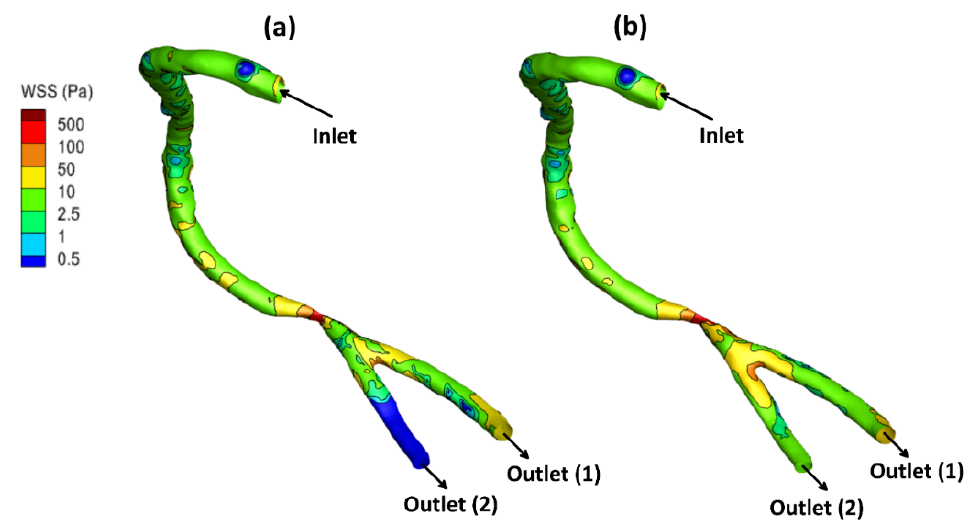
Figure 4. WSS contours for stenotic RCA (model A) at the peak systole of the cardiac cycle: ( a ) elastic wall, ( b ) rigid wall.